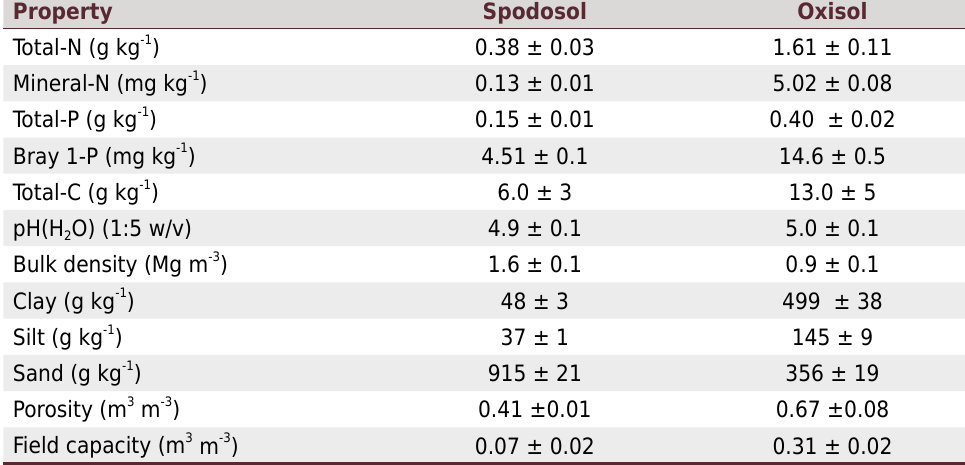
Table 3. Total-N applied to air-dried soils based on the N content in biosolids Equivalent dry Mg ha -1 0.25